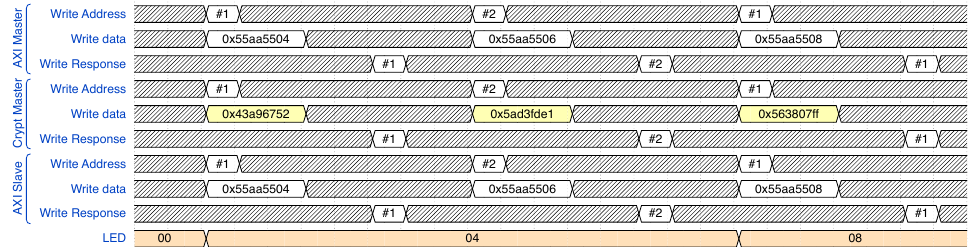
Figure 6. Write transaction from an AXI master to an LED-controlling GPIO slave. 0x55AA5504 data are inserted, encrypted ( 0x43A96752 ) by the proposed IP, then decrypted by the proposed IP in the destination, and finally passed to the end slave that finally changes the values of the LEDs from 0x00 to 0x04 .